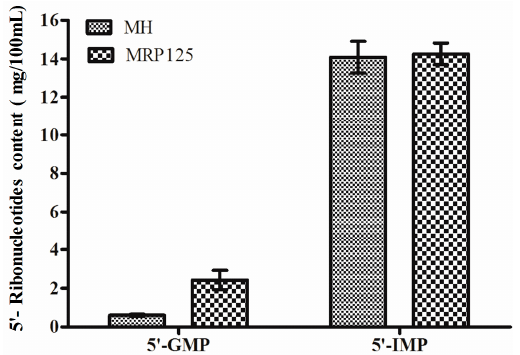
Figure 5. Content of 5 ′ -ribonucleotides in mushroom hydrolysate (MH) and Maillard reaction products prepared at 125 °C (MRP125).